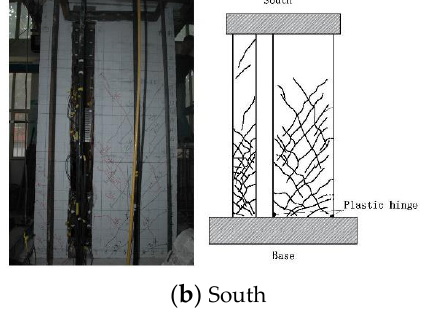
Figure 6. Failure model of specimen R-0.1.